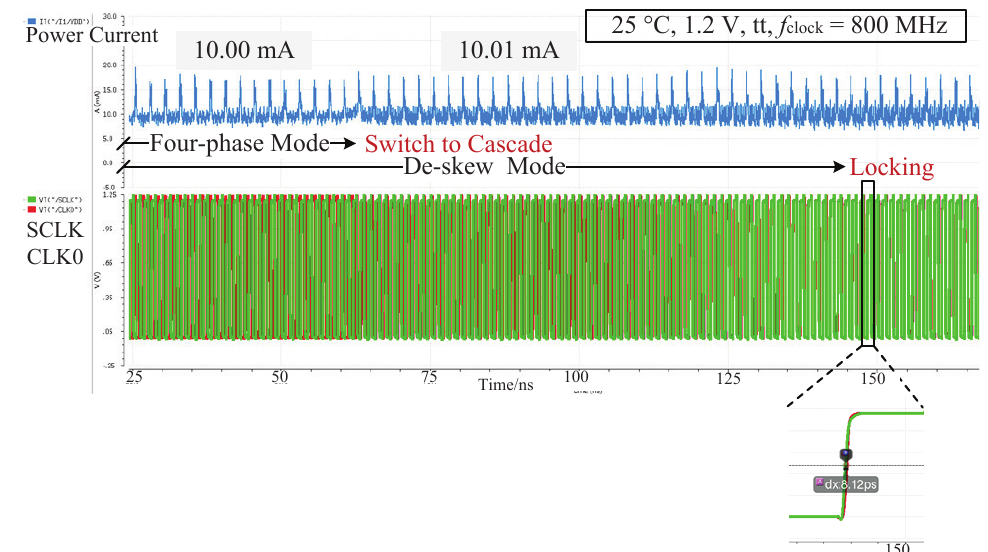
Figure 10. The power current and alignment error in parallel-cascaded